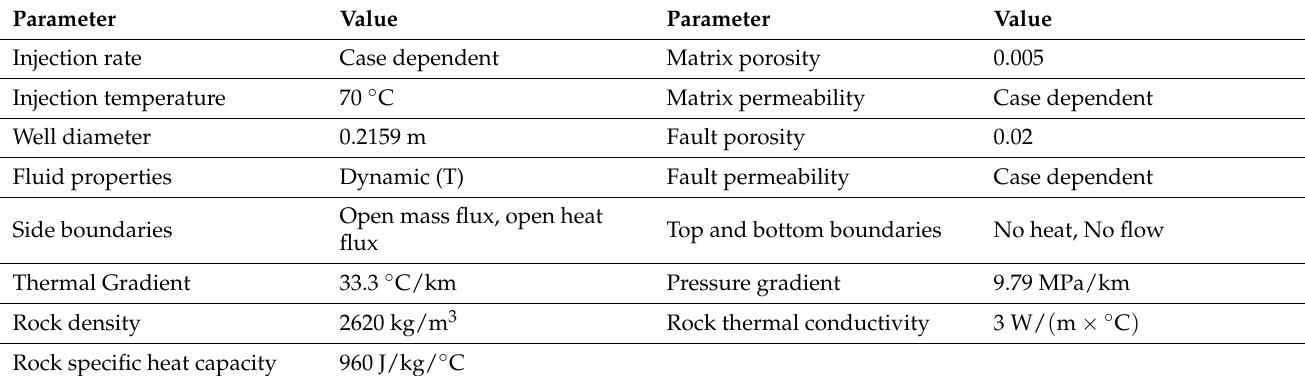
Table 3. Rock and fluid properties for the United Downs geothermal system, as defined for the numerical